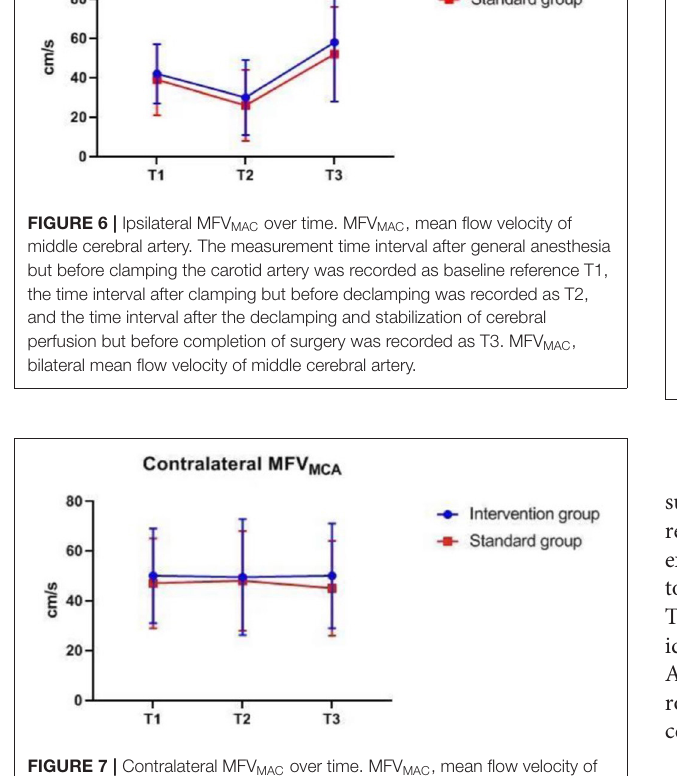
FIGURE 7 | Contralateral MFV MAC over time. MFV MAC , mean flow velocity of middle cerebral artery. The measurement time interval after general anesthesia but before clamping the carotid artery was recorded as baseline reference T1, the time interval after clamping but before declamping was recorded as T2, and the time interval after the declamping and stabilization of cerebral perfusion but before completion of surgery was recorded as T3. MFV MAC , bilateral mean flow velocity of middle cerebral artery.